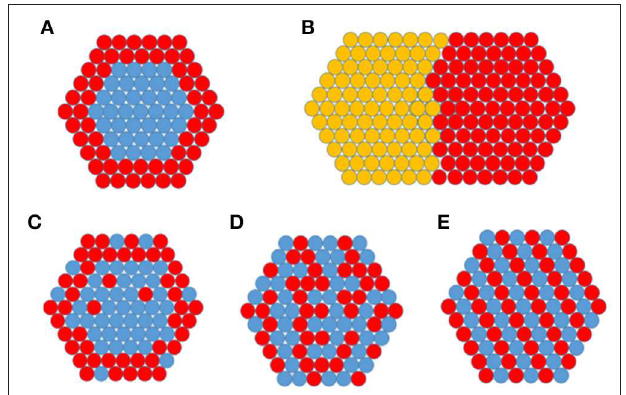
FIGURE 1 | Schematic representation of the examples of some possible configurations for bimetallic NPs: (A) core-shell, (B) segregated/Janus particle, (C) surface segregated, (D) disordered alloy, (E) ordered alloy. The illustrations display cross sections of the NPs showing an hypothetical face-centered cubic (FCC) (111)